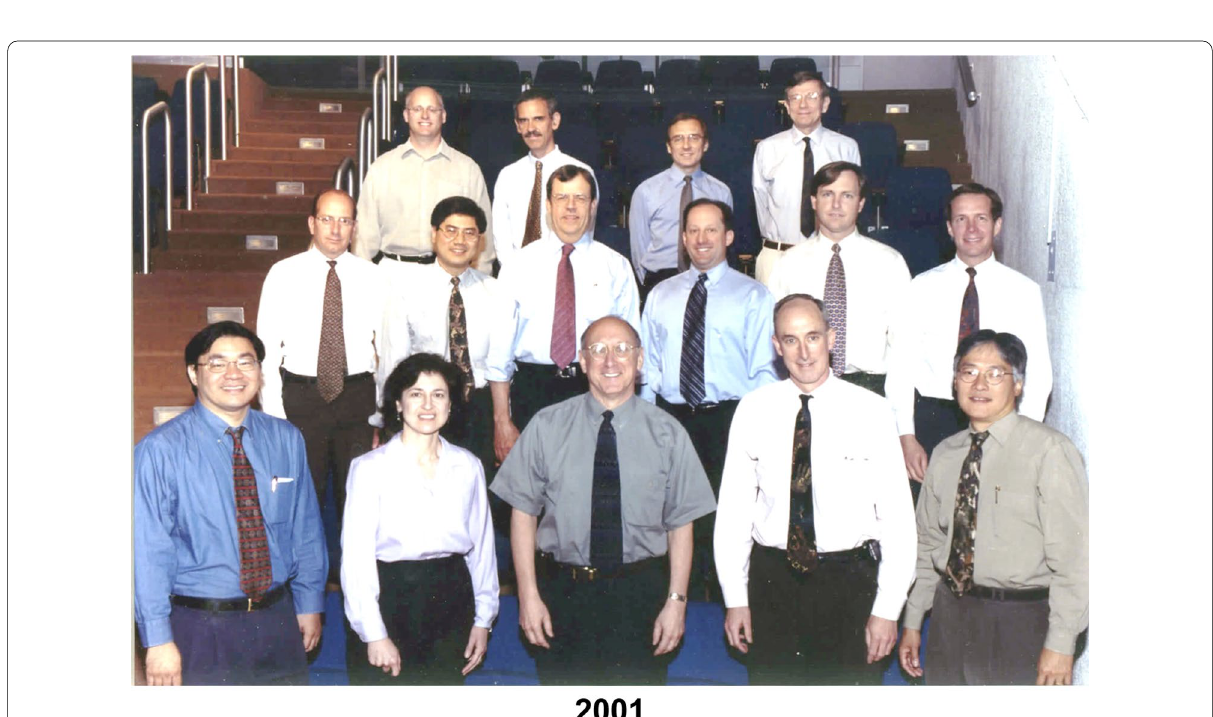
Fig. 5 Senior members of the Surgery Branch in 2001. Front row: Patrick Hwu, Suzanne L Topalian, Steven A. Rosenberg, H. Richard Alexander, James C. Yang; Second row: David S. Schrump, Dao Nguyen, David N. Danforth, Steven K. Libutti, David L. Bartlett. Douglas J. Schwartzentruber; Third row: Richard A. Morgan, Paul F. Robbins, Nicholas P. Restifo, John R.